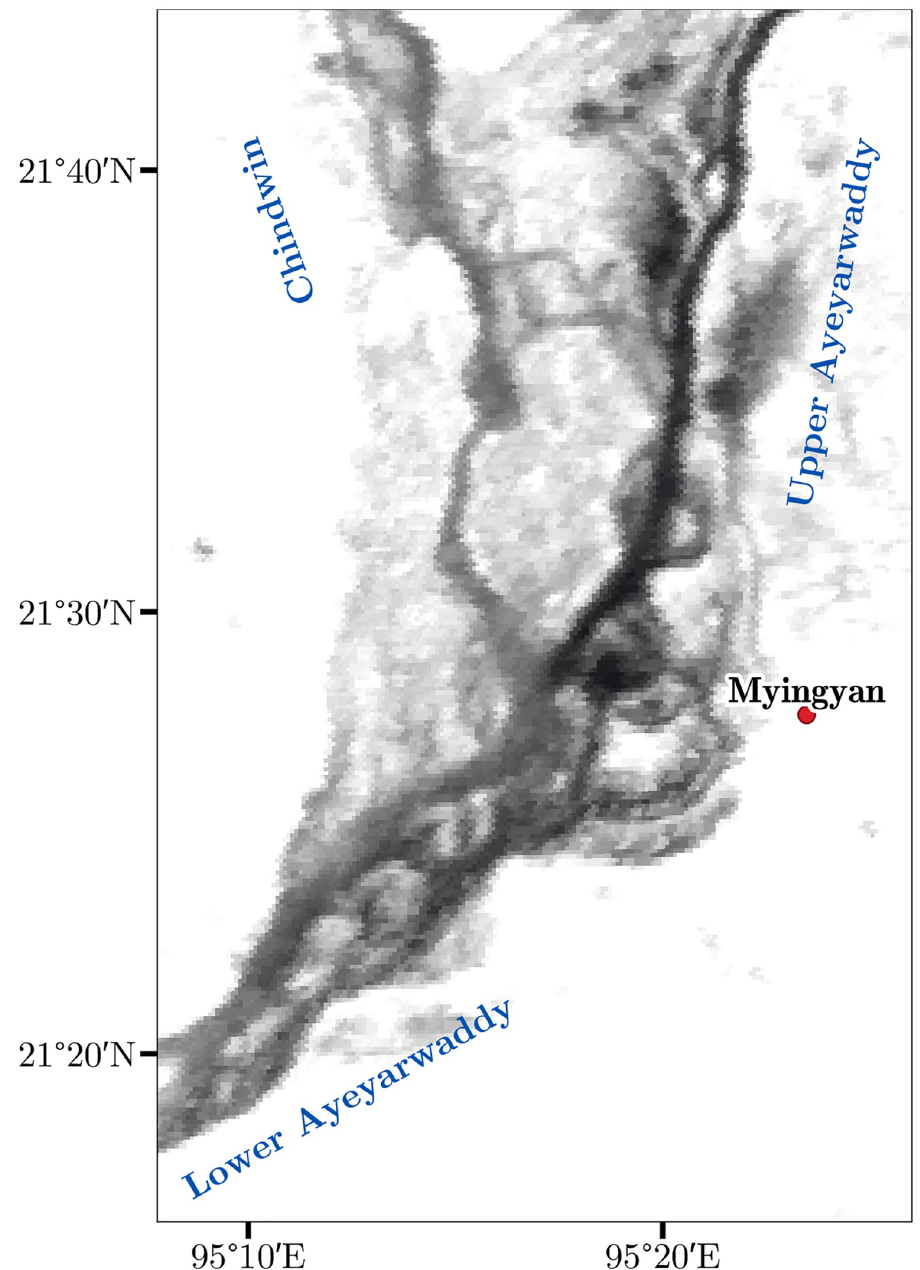
Fig 9. Prediction of the sediment concentration from the river discharge. Averages for the observed years smoothed over a 30-day interval.